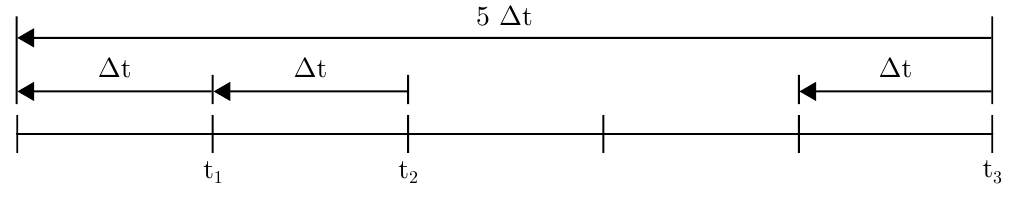
Figure 9. Timeline—variation of ∆ t at different reference points in